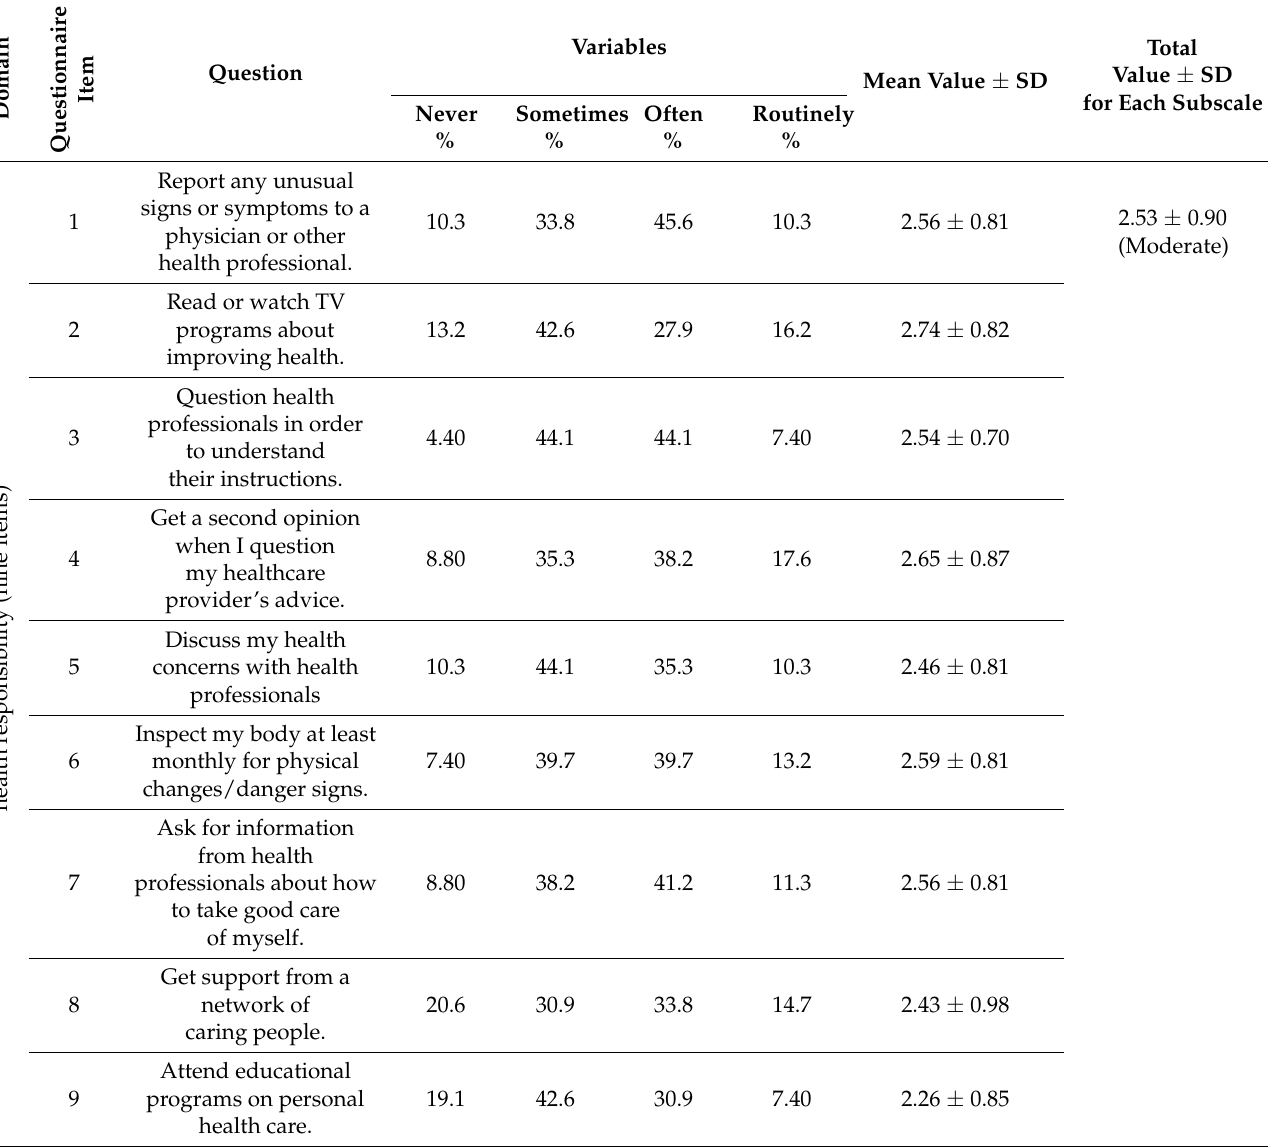
Table 2. The distribution of the answers to the Health-Promoting Lifestyle Profile II questionnaire, the average value, and the SD of the